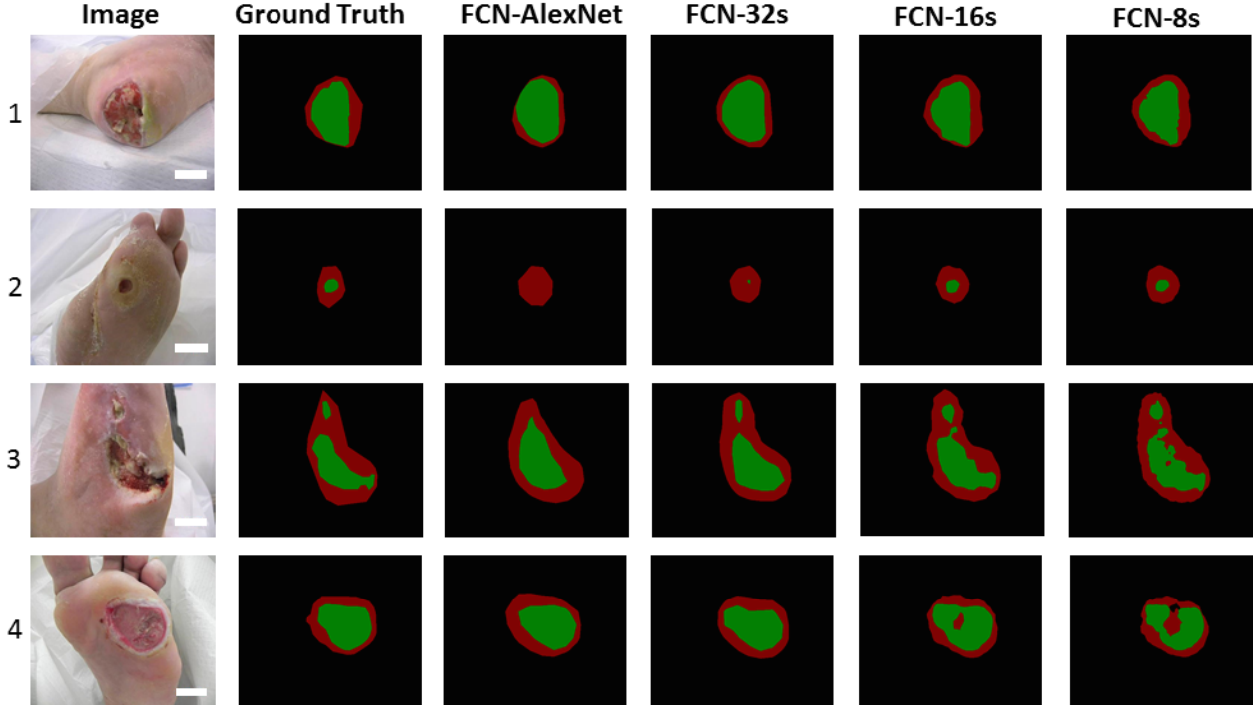
Figure 13. Four different FCN models (columns 3 – 6) and the gold standard (column 2) demonstrate the segmentation of the DFI area (green) from the skin (red) around it [51]. the segmentation of the DFI area (green) from the skin (red) around it